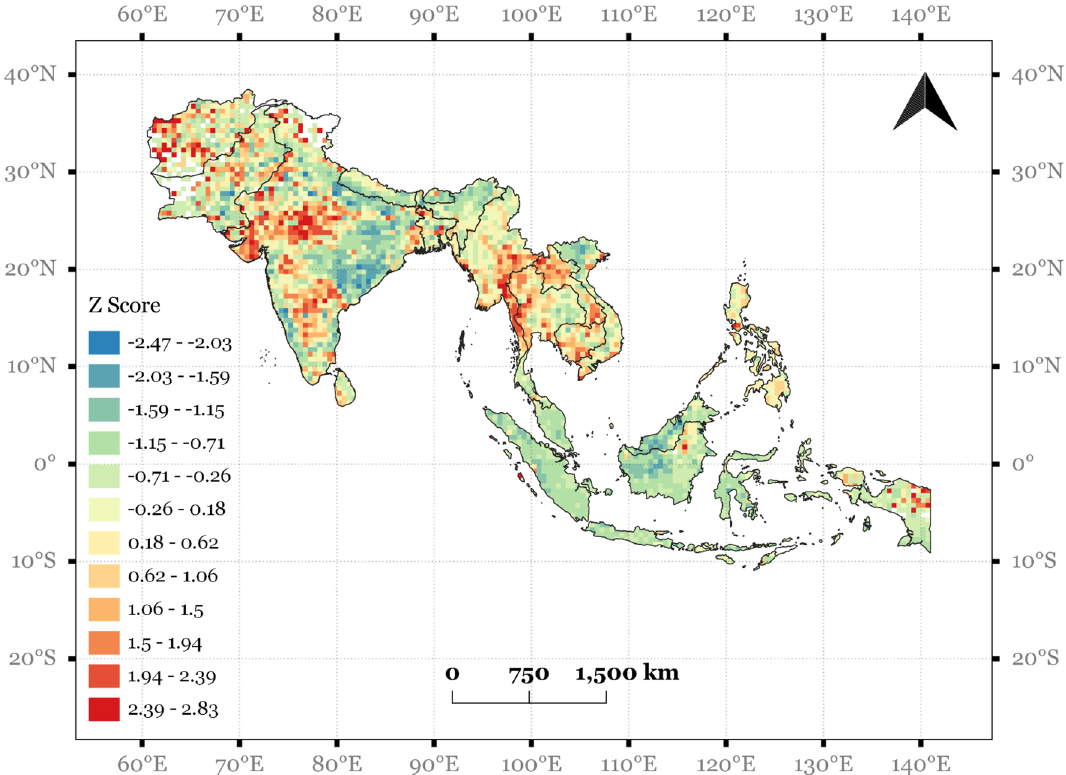
Figure 6. Z-score map of fire counts ( FC ) for 2020 pandemic year derived from VIIRS fire data from 2012– 2020. The negative scores indicate places where there was reduced FC and positive values indicate increased FC (Map created using QGIS